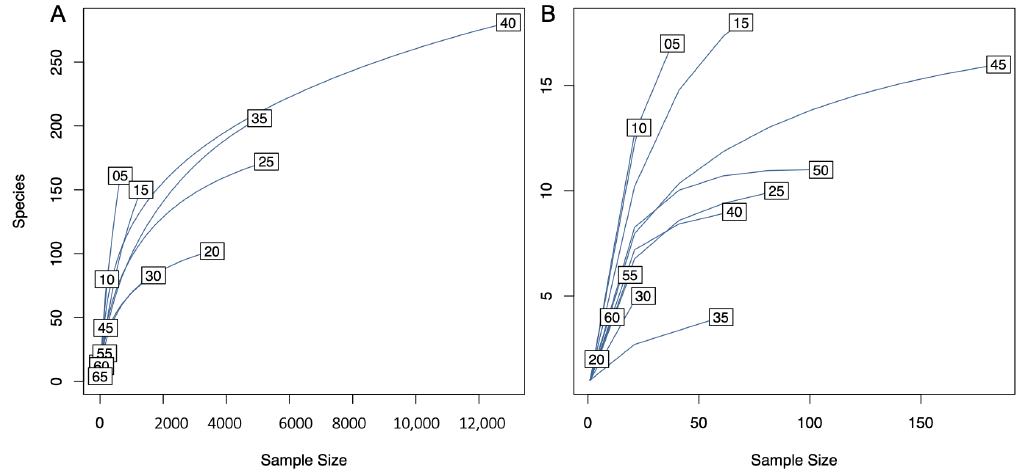
Figure 6. Rarefaction curves of Polychaeta ( A ) and Sipuncula ( B ) gamma species richness across 5°-latitudinal bands. The tags at the tip of the curve indicate the latitudinal band. Curves reaching an asymptote indicate that the latitudinal band has been mostly sampled and only a few species remain unknown.